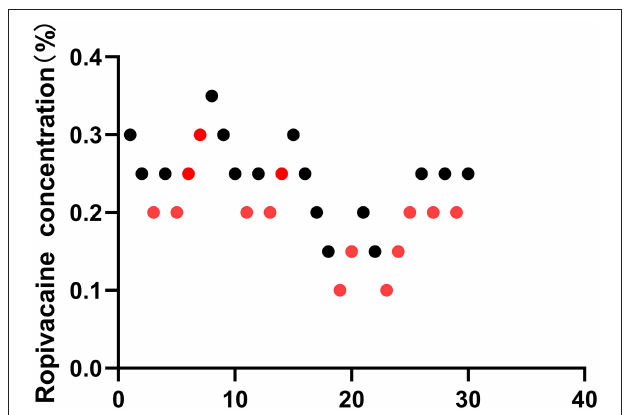
FIGURE 1 | Sequential block results of ultrasound-guided Interscalene Brachial Plexus Block using 10ml ropivacaine according to the Dixon and Massey up-and-down method.